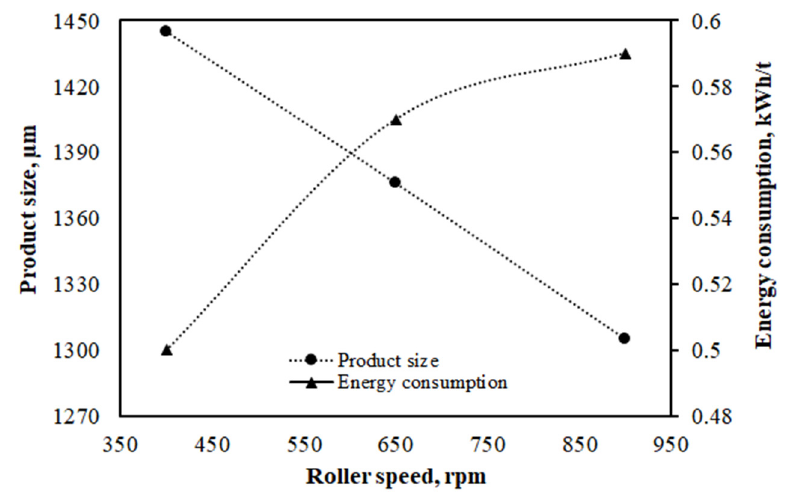
Figure 6. Effect of roller speed on product size and energy consumption at 1.2 mm gap and 12 kN applied load.